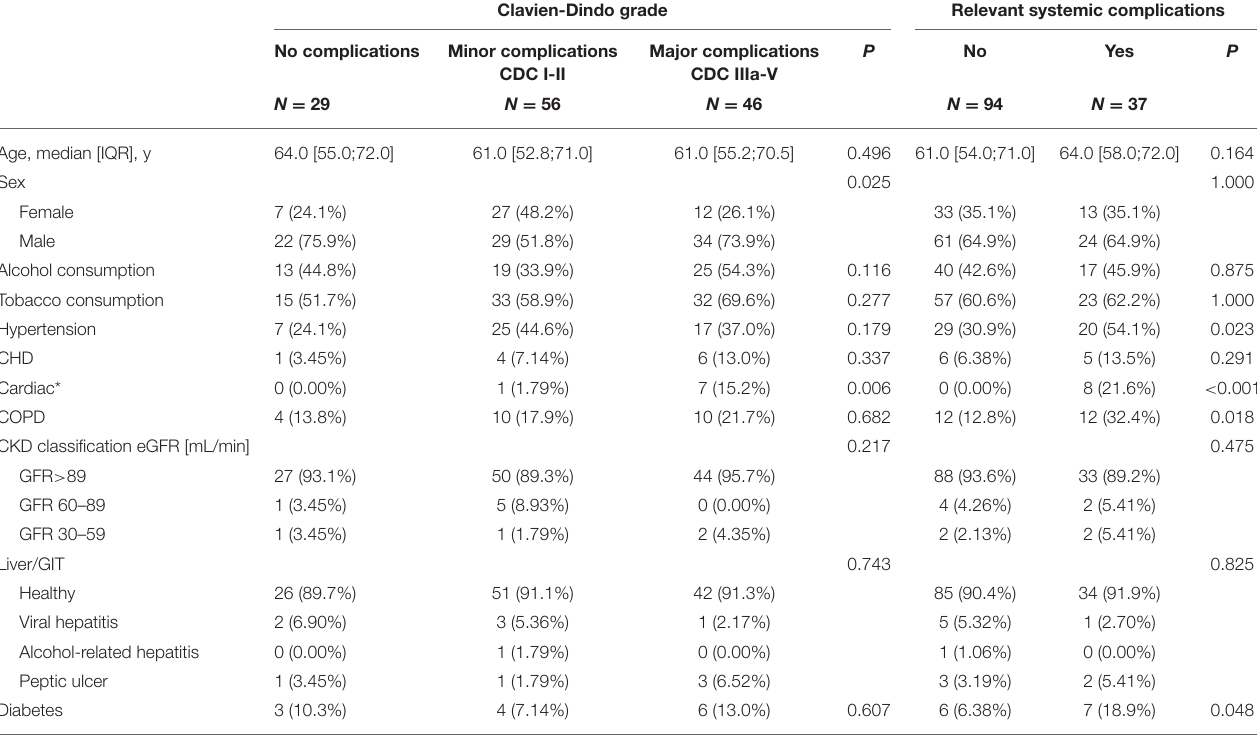
TABLE 1 | Baseline and clinical